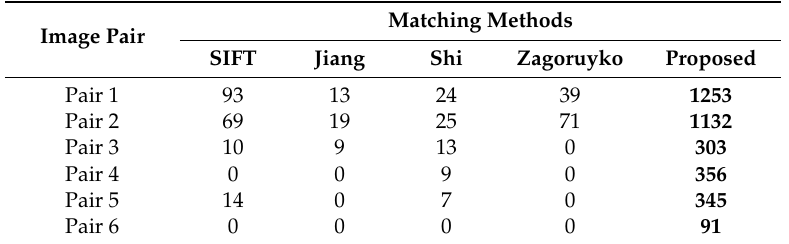
Table 2. NCM values of each method for remote sensing images with complex background variations.